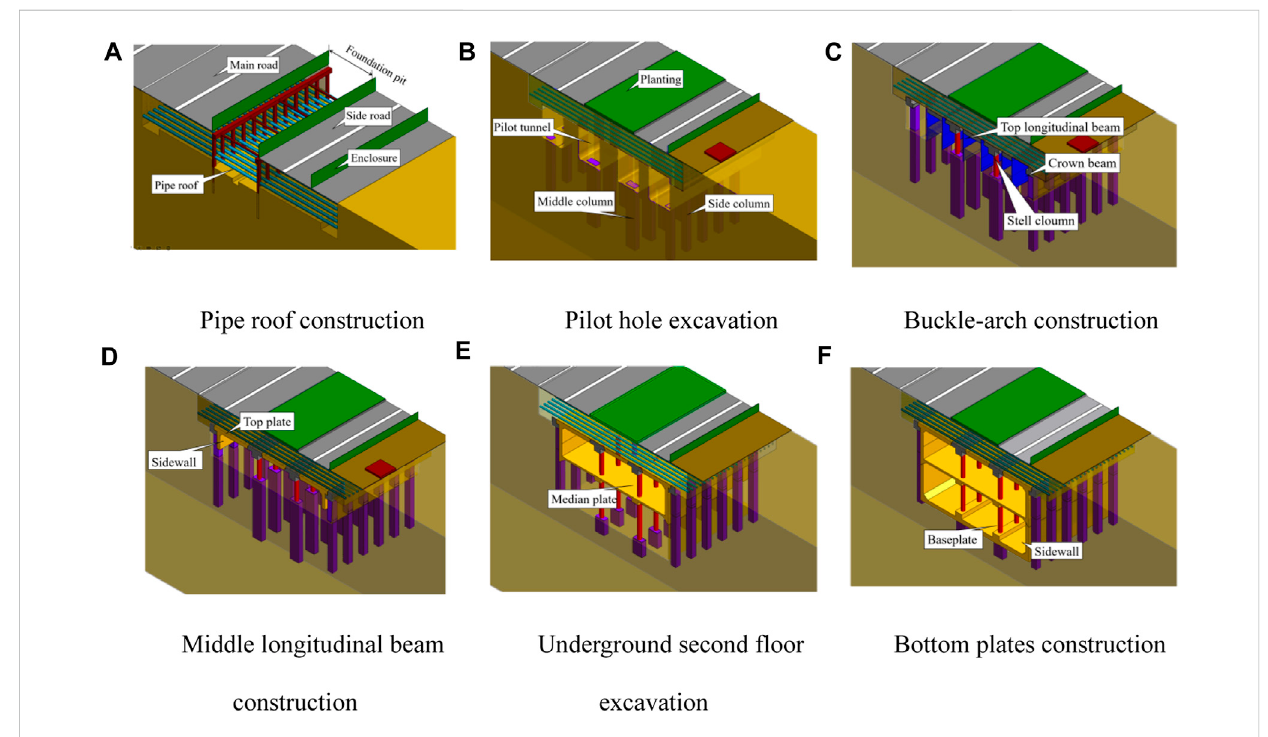
FIGURE 4 Sequence diagram of station construction.